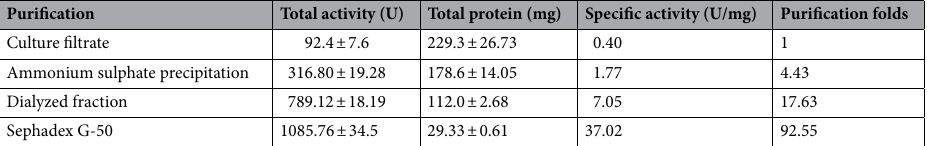
Table 1. Purification steps of Apr-BO1. The values are the mean of three replicates ± standard deviation.